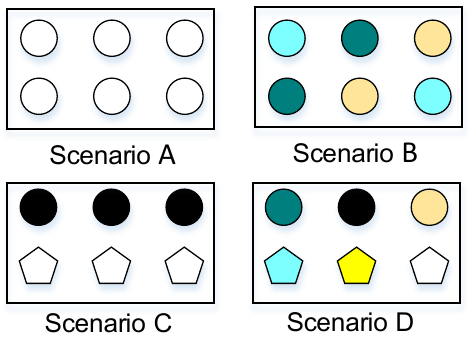
Figure 3. Schematic diagram of heterogeneity.